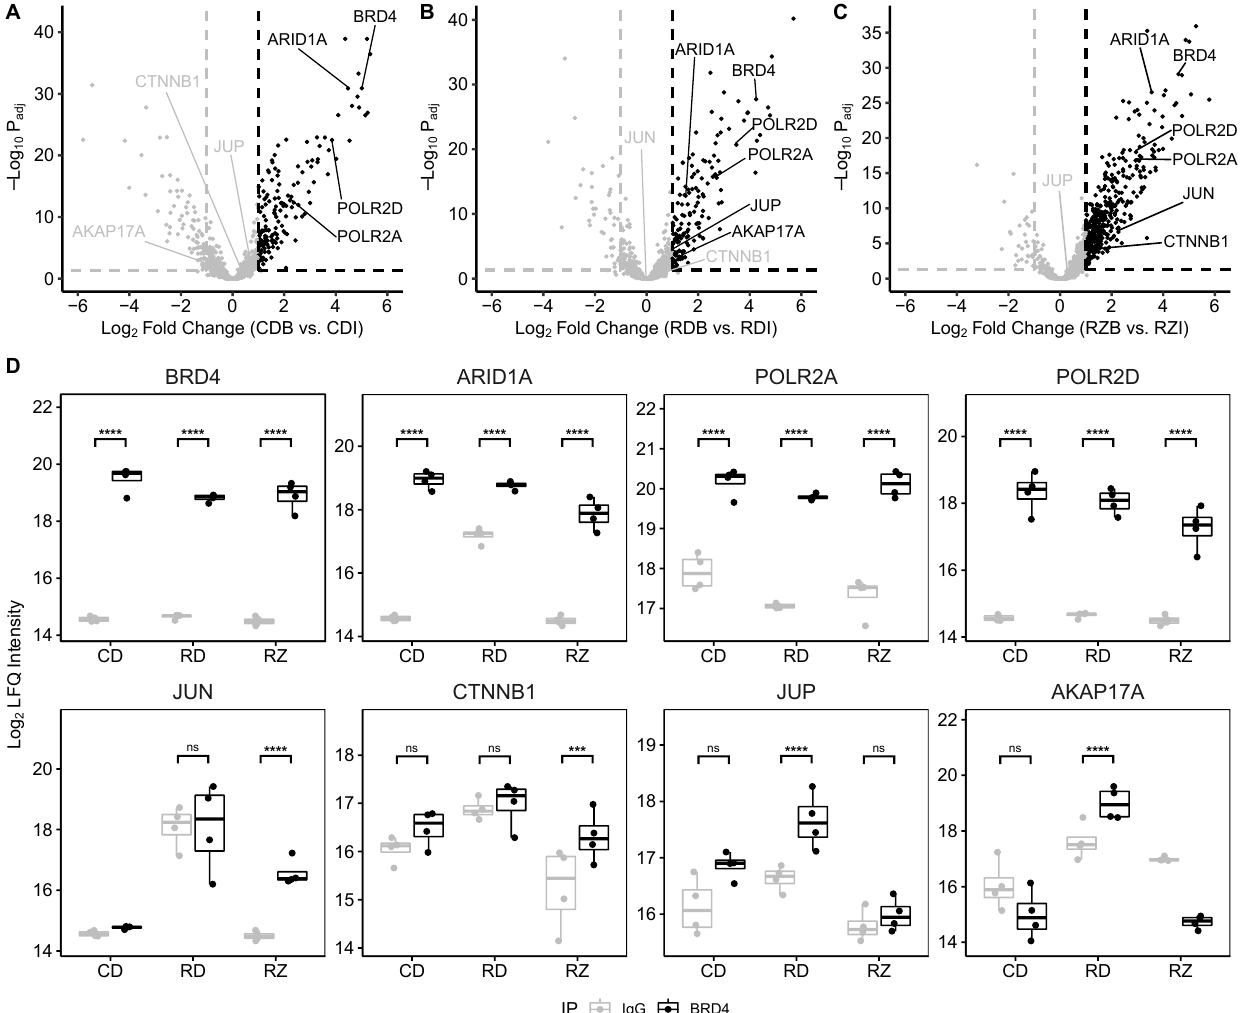
Figure 3. Sample reproducibility and inter-group variance. ( A ) Principal component analysis of per-sample Log abundances demonstrates good reproducibility within groups and separation between groups. ( B ) Heatmap with Pearson correlation scores between all samples (biological and technical replicates) in the experiment.